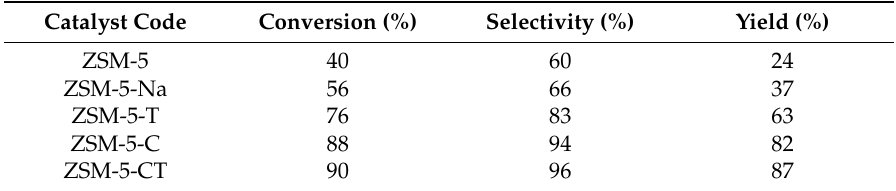
Figure 6. Effect of reaction temperature on the percentage of anisole conversion over treated and untreated zeolite catalysts. Untreated zeolite (ZSM ‐ 5) is in black, ZSM ‐ 5 ‐ NA is in red, ZSM ‐ 5 ‐ T is in green, ZSM ‐ 5 ‐ C is in blue, and ZSM ‐ 5 ‐ CT is in purple. Table 5. The percentages of conversion, selectivity, and yield for Friedel ‐ Crafts acylation of anisole and propionic anhydride catalyzed by untreated and treated zeolites at 24 h and 100 °C.